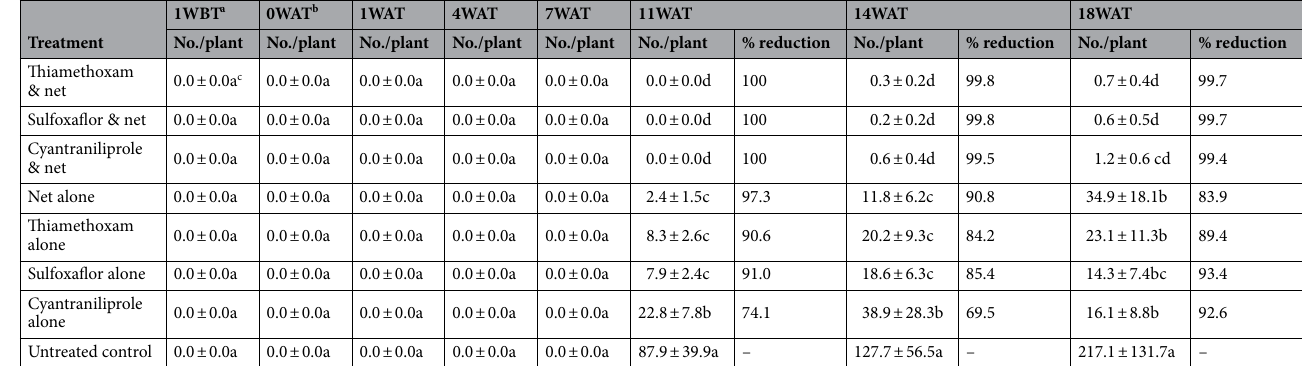
Table 4. Effects of different treatments on Bemisa tabaci egg populations during the whole growing season (greenhouse trial II, 2019). a WBT, weeks before transplanting; 1 WBT is the time of root drenching. b WAT, weeks after transplanting; 0 WAT is the time of seedling transplanting; 11 WAT is the time of first fruit harvest; 18 WAT is the end of the greenhouse trials. c In the columns, the data are the means ± SD of four replications, with 10 plants per replicate. Means followed by the same letter are not significantly different at P = 0.05 level according to the LSD